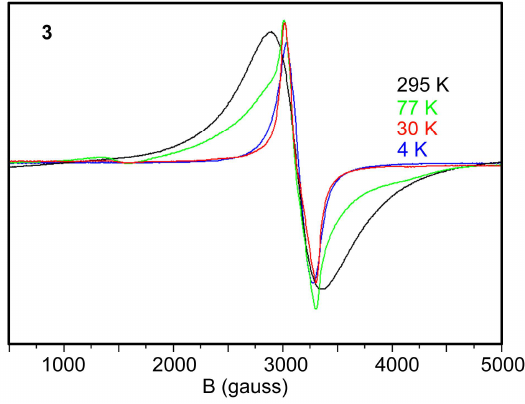
Figure 6. X-band EPR spectra at 4 K to 295 K for a microcrystalline sample of 3 .